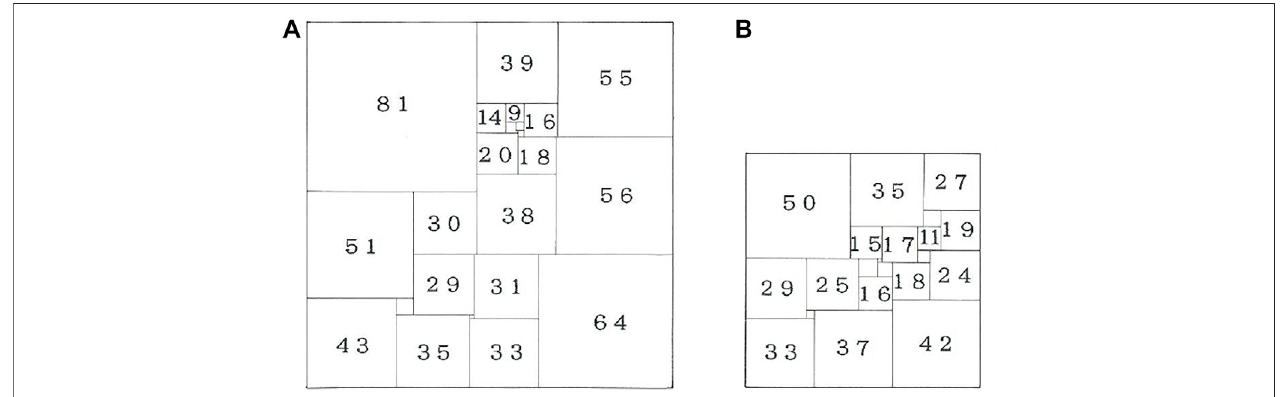
FIGURE 1 | Two perfect squared squares. (A) Willcock ’ s compound square of order 24. The sequential lengths of its elements are {81, 64, 56, 55, 51, 43, 39, 38, 35,33,31,30,29,20,18,16,14,9,8,5,4,3,2,1}. (B) Duijvestijn ’ ssimplesquareoforder21.Theyare{50,42,37,35,33,29,27,25,24,19,18,17,16,15,11,9,8,7, 6, 4, 2}.